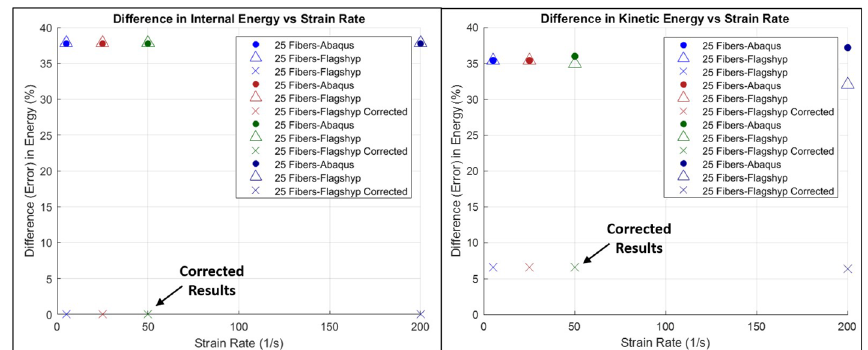
Fig. 14 Comparison of internal and kinetic energy from Abaqus and FM models with twenty-five embedded elements with reference to the energy of a solid element with no embedded elements. The additional strain energy from the volume redundancy is constant with changes in strain rate as expected and is easily corrected for using FM Corrected. The volume redundancy also adds extra mass which ought to increase the error as the nodal velocities increase with the increasing applied strain rate. This effect occurs at very high strain rates. FM Corrected is able to bring the error in energy down to less than 10% for all